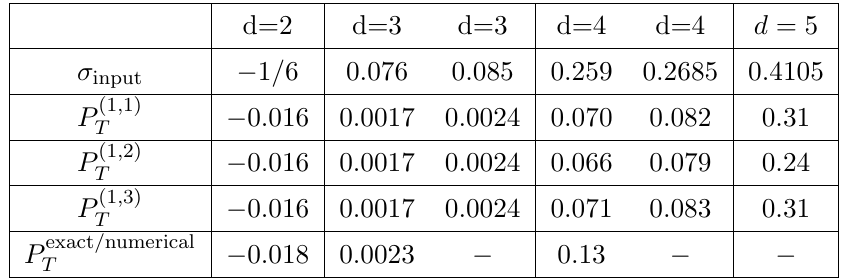
Table 6 . The (cid:12)rst order estimates of the OPE coe(cid:14)cient P T in various dimensions and the exact value [104] or the numerical bootstrap values [77]. The input data are from [77, 78]. Some of the numerical values are absent. We only show two signi(cid:12)cant (cid:12)gures of P T . The 2d estimate is close to the exact value, but the 3d and 4d estimates are less consistent with the bootstrap results in